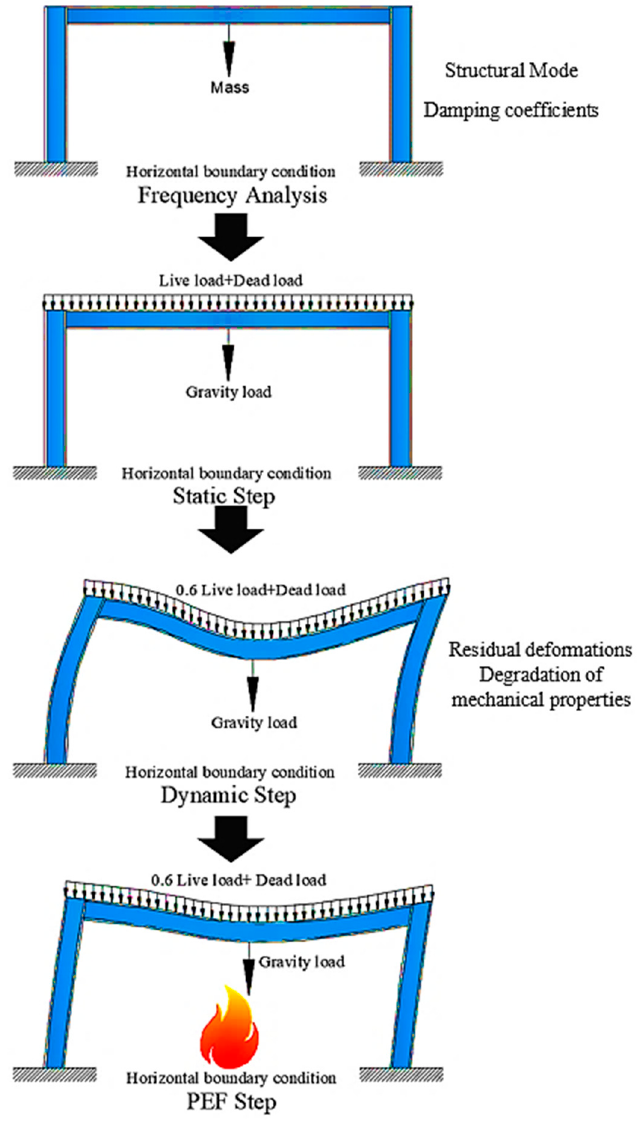
Figure 5. Methodology of the sequential